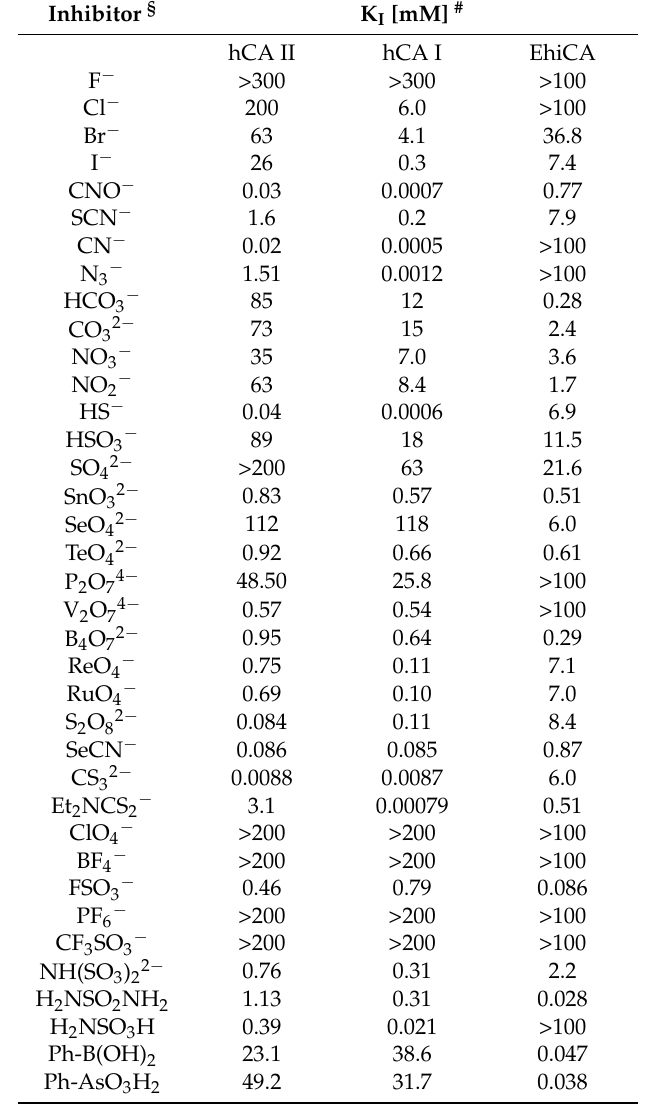
Table 2. Inhibition constants of anionic inhibitors against the α -CA isoforms hCA II and hCA I, as well as the β -class protozoan enzyme EhiCA, for the CO 2 hydration reaction at 20 ◦ C